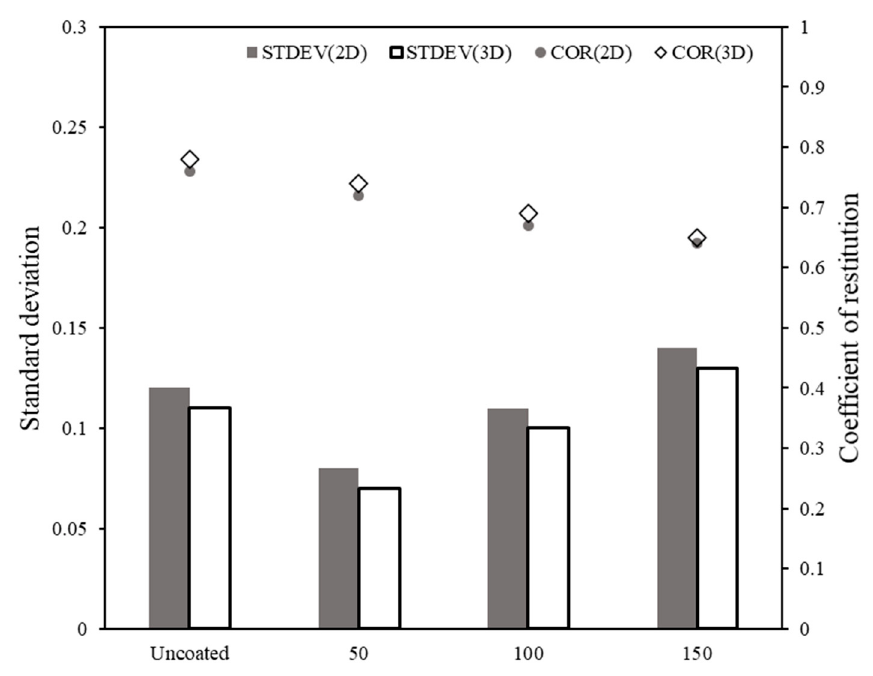
Figure 9. Comparison of 3D and 2D measurements for different coated LBS grains colliding with granitic block at an impact velocity of 2.42 m/s.